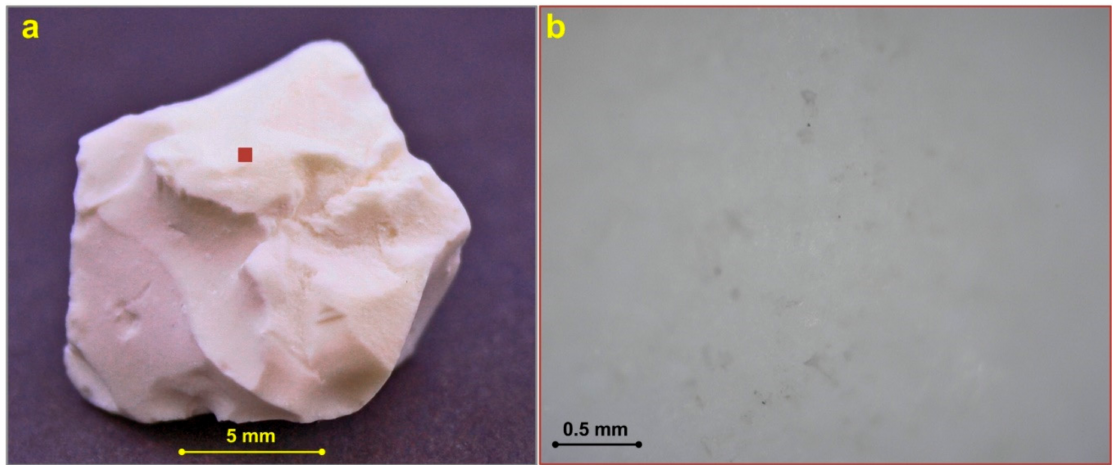
Figure 1. ( a ) Macroscopic and ( b ) optical microscopic images of the Treatments with Consolidant (TCO) consolidating agent after a five-year curing at ambient